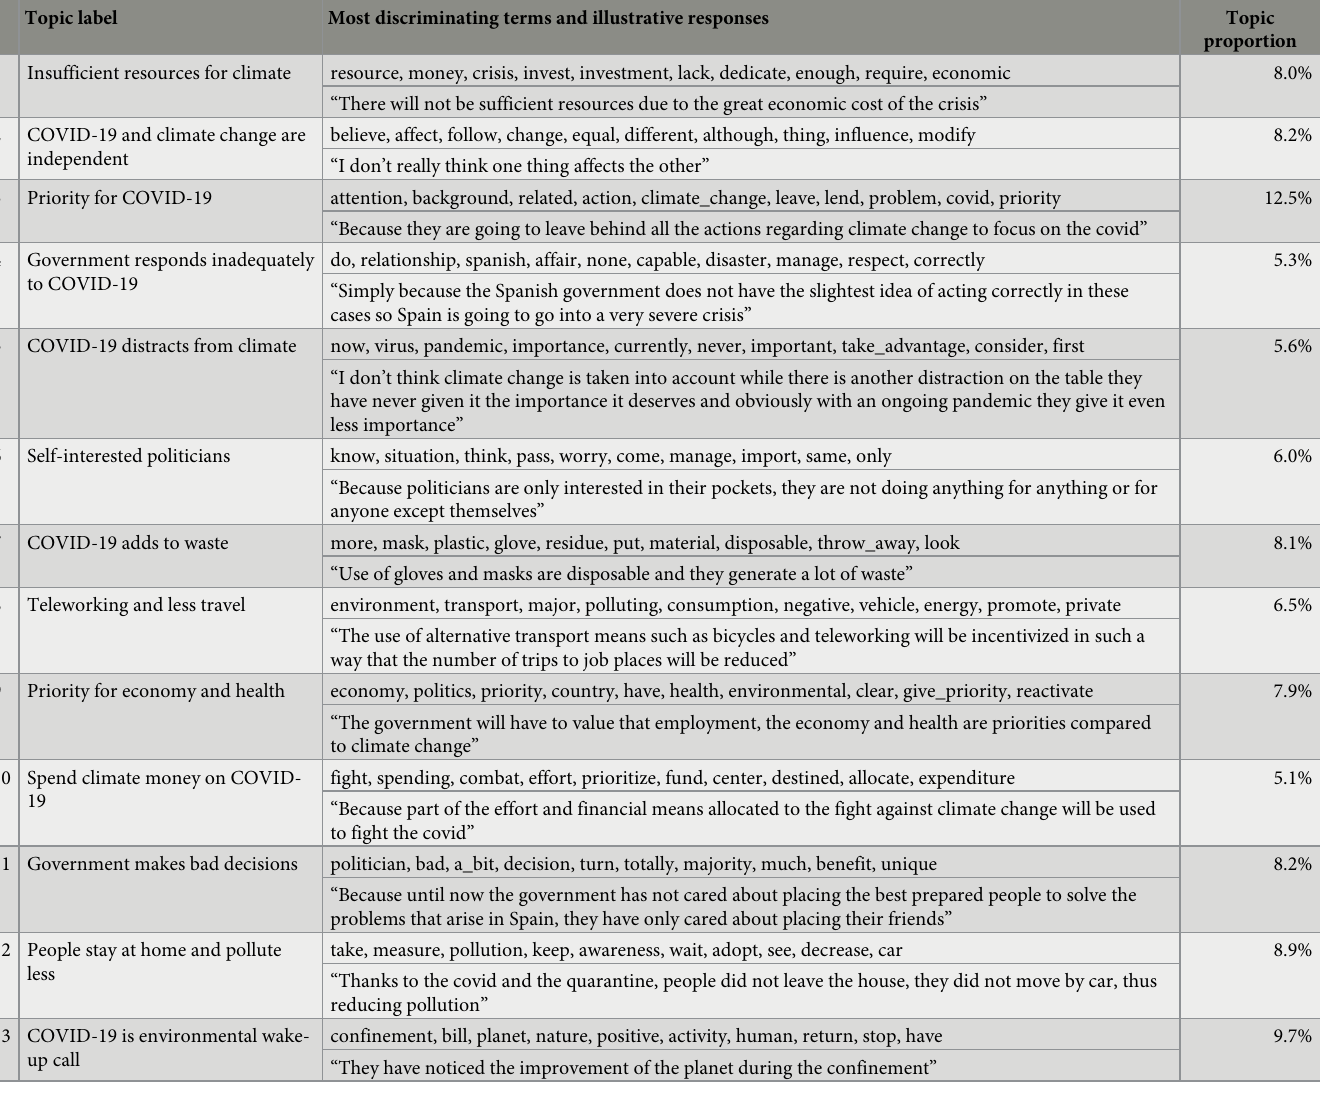
Table 1. Topics identified for responses to the first question on governmental climate